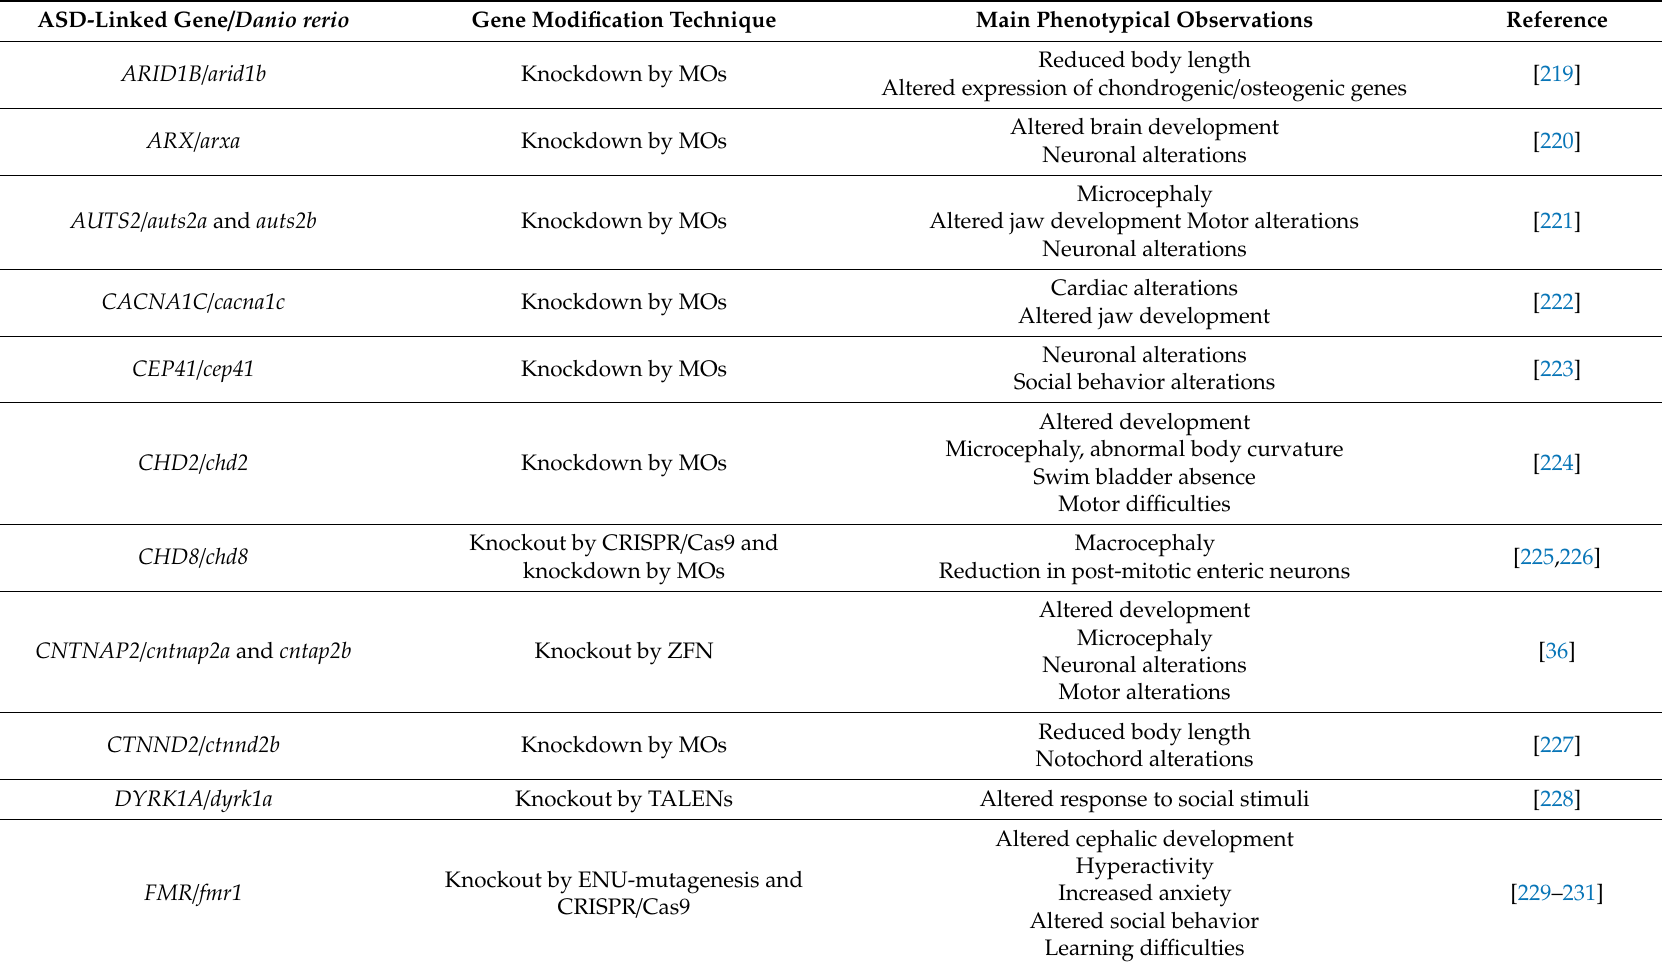
Table 7. Phenotype observed in Danio rerio ASD-associated genes models. Genes are classified with score 1 (high confidence) or score 2 (strong candidate) following the SFARI Gene database [20,21]. In the cases in which several models have been developed, phenotype refers to the characteristics shared by all of